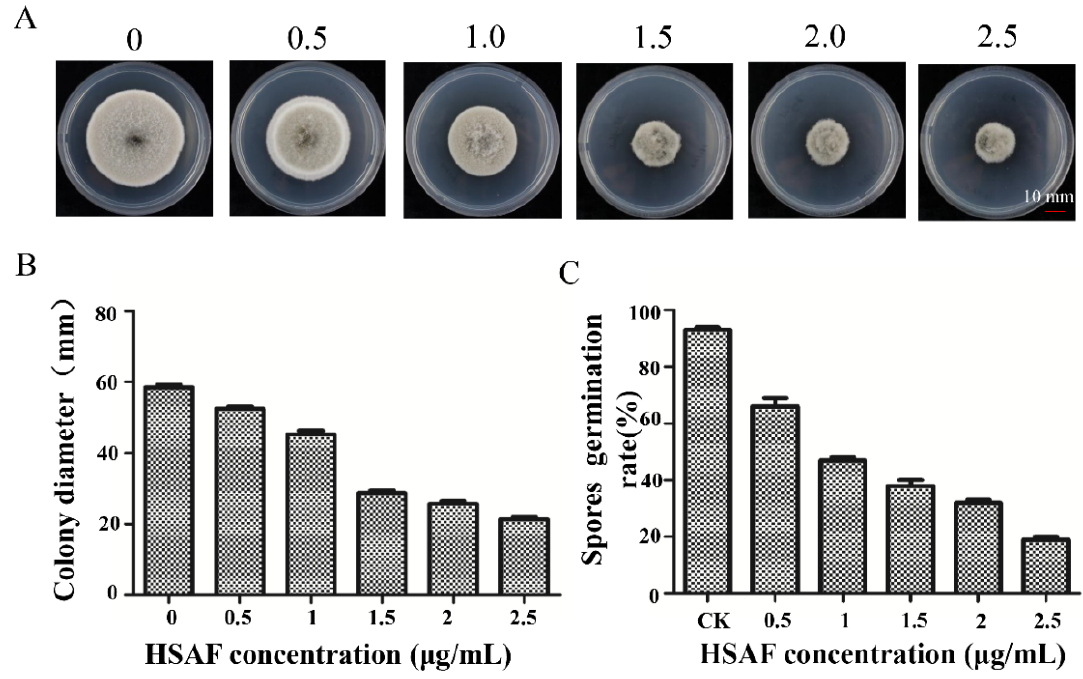
Figure 1. Inhibitory effect of HSAF (Heat ‐ stable activity factor) on A. alternata . ( A ) The inhibitory effect of HSAF on mycelia growth of HN ‐ 5. HSAF was extracted and purified by HPLC (High Performance Liquid Chromatography) using a linear gradient program (Y = 4 × 10 − 5 X + 32.385, X indicates mAu, Y means concentration). The HN ‐ 5 strains were grown on PDA plates supplemented with HSAF (0, 0.5, 1.0, 1.5, 2.0, 2.5 μ g/mL). The colony morphology was documented by a camera after cultured for 5 days. ( B ) Inhibitory effect of HSAF on mycelia growth of HN ‐ 5. The colony sizes were measured using rulers with cross method, and the data of the colonies’ sizes were analyzed using formats in Microsoft Excel 2010. ( C ) Inhibitory activity of HSAF to germination of HN ‐ 5. Spores were collected after being cultured on PDA for 8 days, collected and divided into the tubes with 1 mL PDB medium containing HSAF (0, 0.5, 1.0, 2.0, 2.5 μ g/mL), the germinated spores were counted using hemocytometer, and the data were also analyzed using formats in Microsoft Excel 2010 (Microsoft, Redmond, Washington, DC, USA). Bar = 10 mm. Each experiment was repeated at least three times.